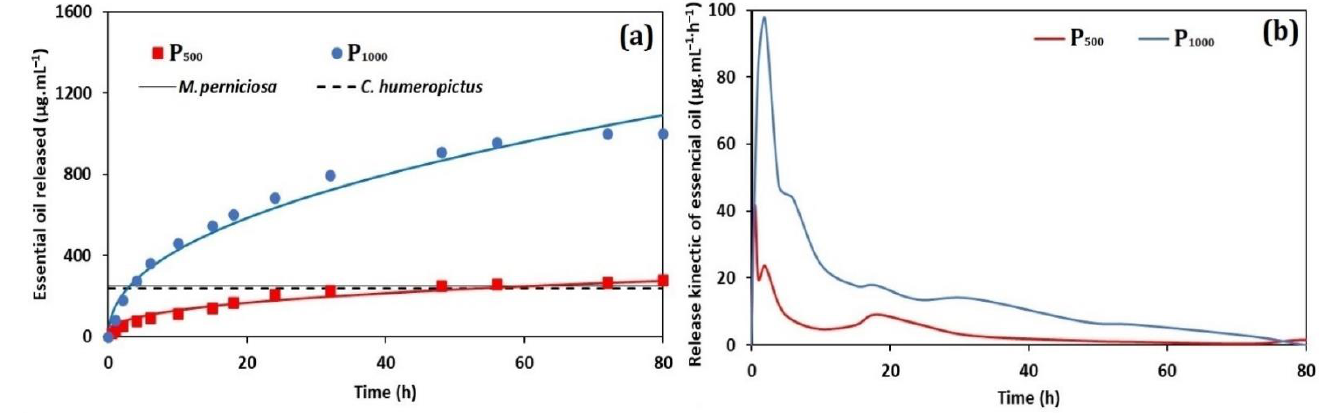
Figure 8. Controlled release curves of the P 500 and P 1000 systems: ( a ) concentration of released es- sential oil (µg·mL −1 ), and ( b ) kinetic essential oil release (µg·mL −1 h −1 ). essential oil ( µ g · mL − 1 ), and ( b ) kinetic essential oil release ( µ g · mL − 1 h − 1 ).